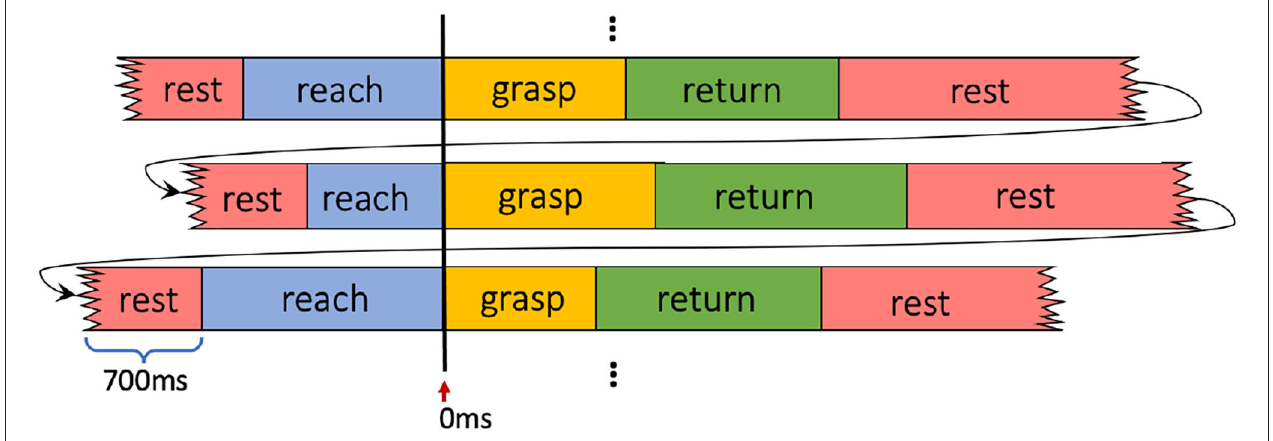
FIGURE 6 | Time alignment for EMG windows of validation